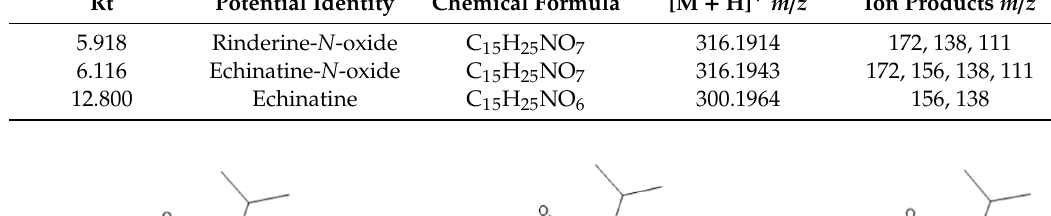
Table 2. LC / MS analysis of PAs extract of R. graeca . Table 2. LC/MS analysis of PAs extract of R. graeca.